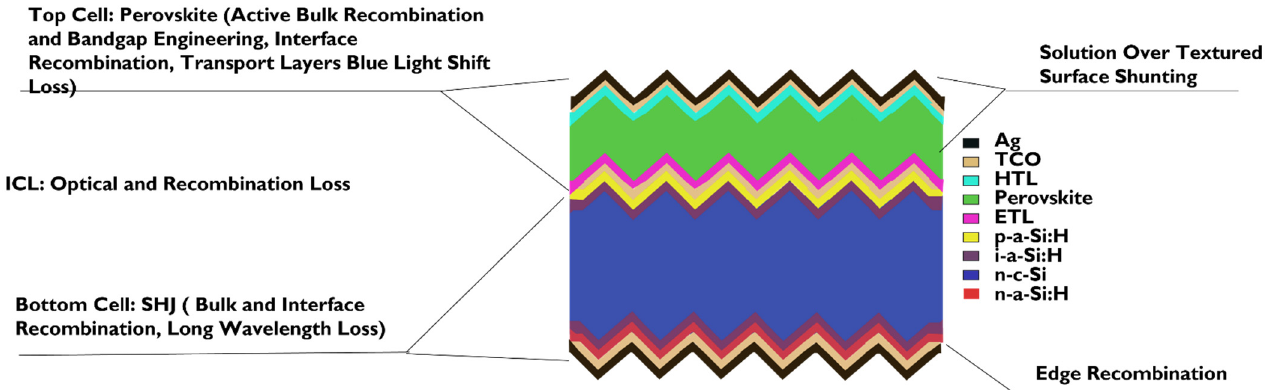
Figure 6. An illustration of the Generic 2T perovskite silicon tandem major loss mechanisms with each set of layers light spectrum absorbance adapted from various literature (The surface morphology may vary from flat surface/partially textured to the fully textured surface). The purple circles represent the modified ICL layer (i.e., nanocrystalline materials). [Reprinted/Adapted] with permission from [ref [219]] © The Optical Society.